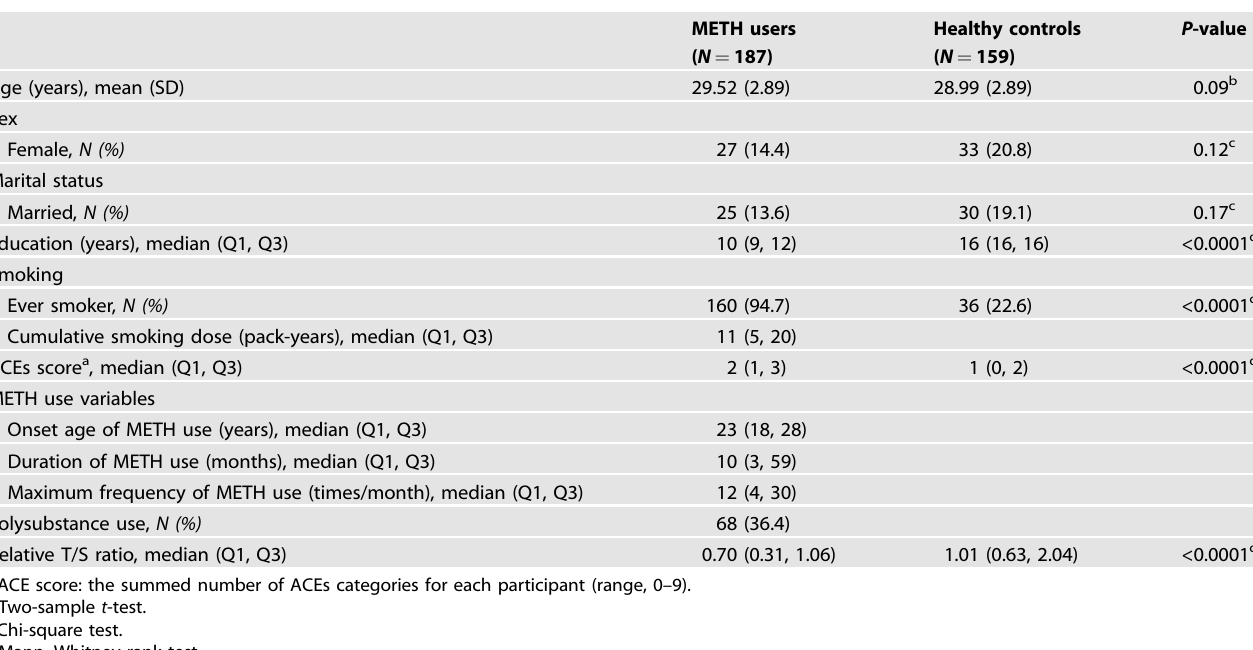
Table 1. Demographic and clinical characteristics for methamphetamine (METH) users and healthy controls.